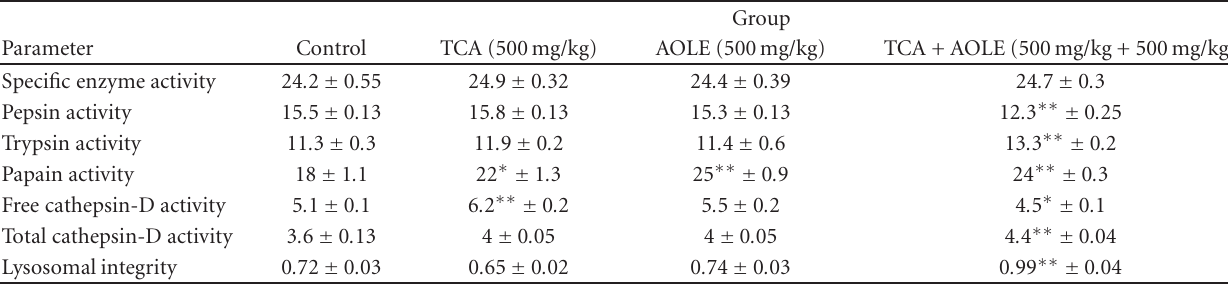
Table 1: Proteolytic enzyme activities ( µ g-released tyrosine/mg substrate protein) and lysosomal integrity (total/free cathepsin-D activity) in liver tissue of rats treated by aqueous olive leaf extract (for one month) after trichloroacetic acid carcinogenic challenge (for 5 days). Values are expressed as mean ± S.E ( N =